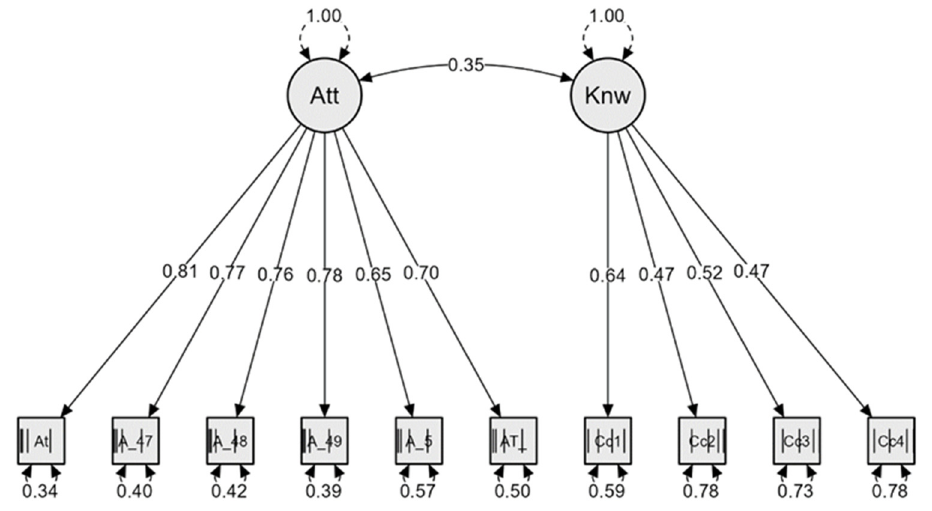
Figure 6. Factor loadings for the content creation area.